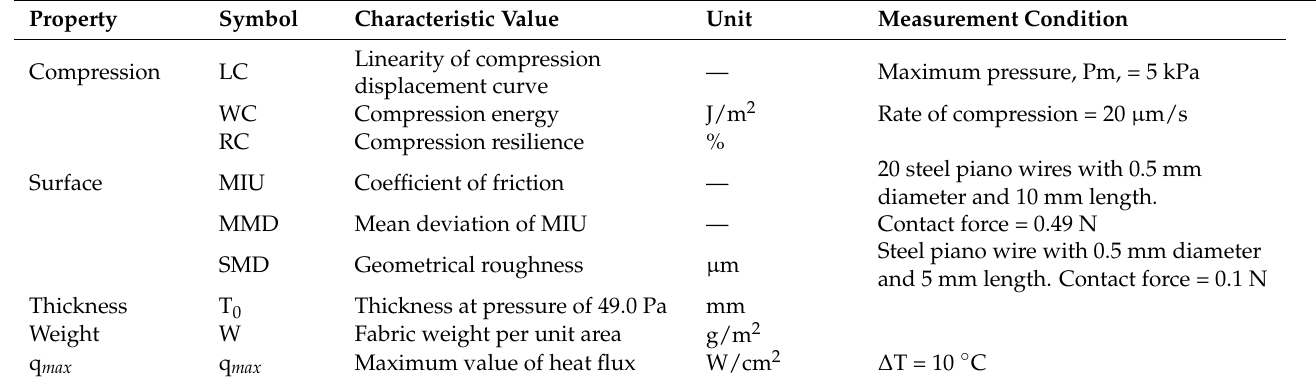
Table A1. Characteristic values and standard conditions of measurement of the physical